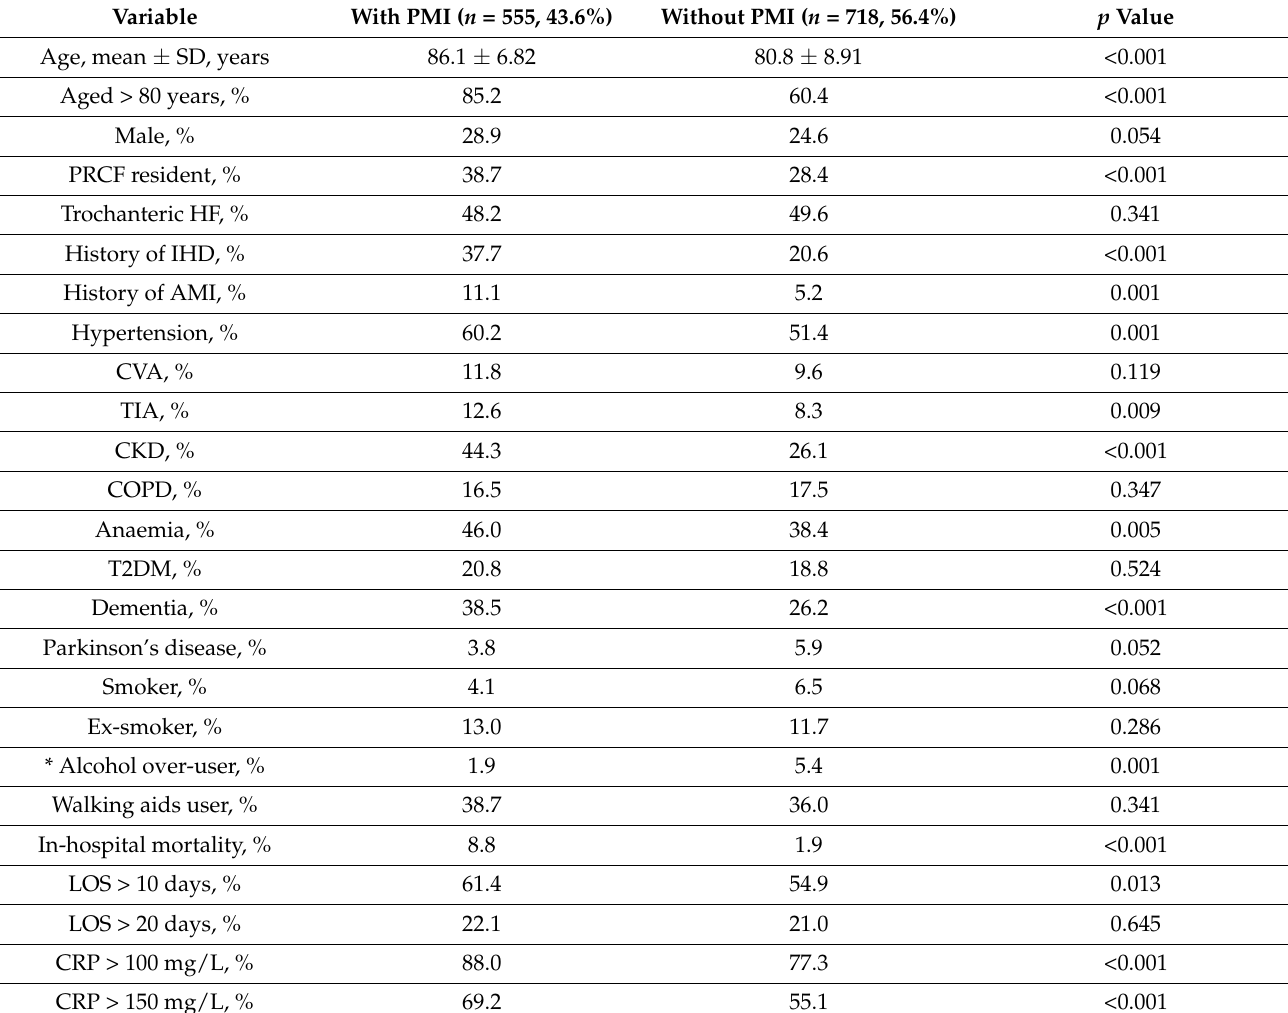
Table 2. Clinical characteristics and outcomes in hip fracture patients with and without postoperative myocardial injury